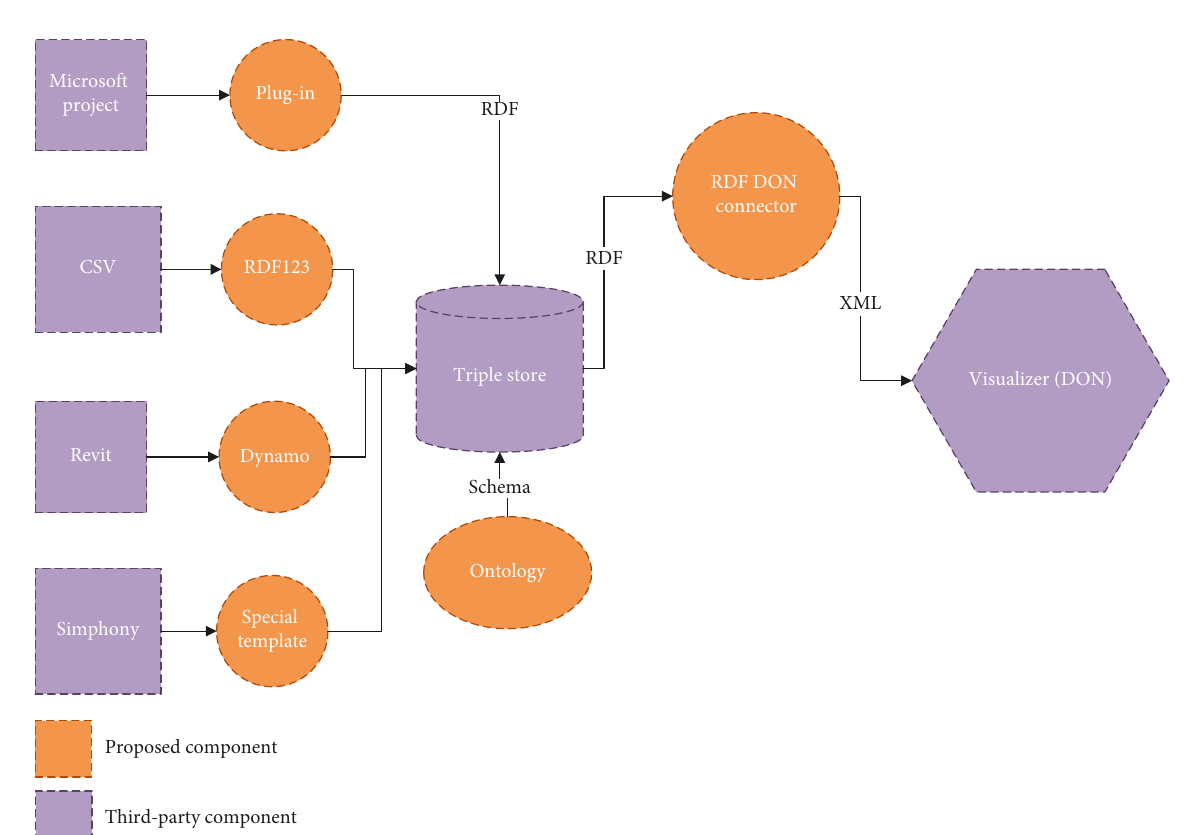
Figure 4: A schematic drawing of the proposed